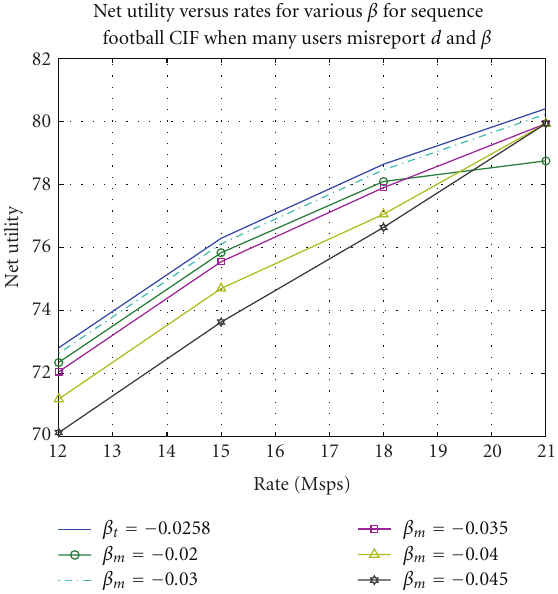
Figure 17: Net utility function versus rate at various values of parameter β for sequence football CIF and other misreports: β t = true value; β m = misreprted value. Figure 18: Net utility function versus rate at various values of